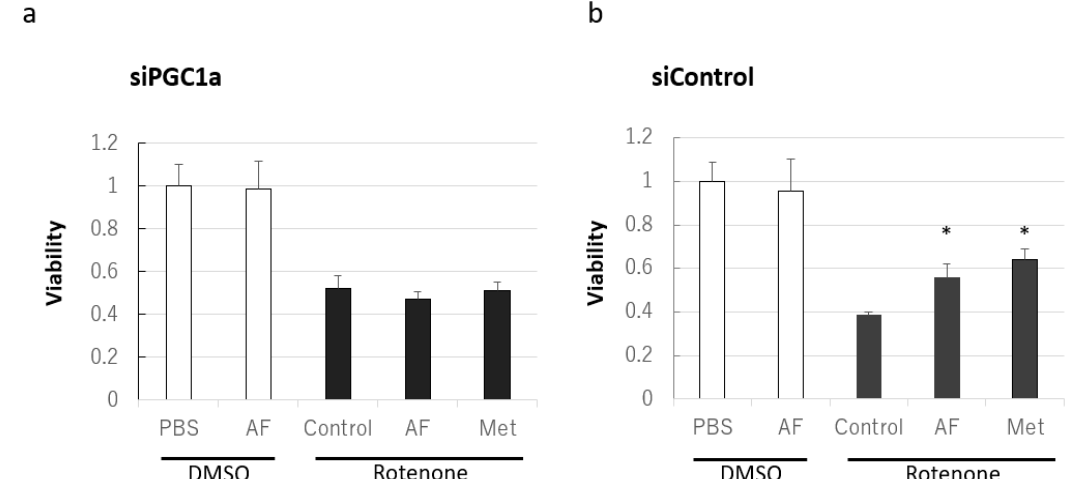
Figure 6. Effects of PGC-1 α silencing on rotenone-induced cytotoxicity in cultured PC12 cells treated with 1,5-AF or metformin. ( a ) Silencing of PGC-1 α by PPARGC1A small interfering RNA (siRNA) attenuated the protective effects of 1,5-AF and metformin on rotenone-induced cytotoxicity, evaluated using the MTT assay (one-way ANOVA followed by Dunnett’s test). ( b ) 1,5-AF and metformin protect against rotenone-induced cytotoxicity in negative control siRNA-transfected cells, evaluated using the MTT assay (one-way ANOVA). All data are expressed as the mean ± standard error of the mean. * p < 0.05. AF, 1,5-anhydro-D-fructose; DMSO, dimethyl sulfoxide; Met, metformin; PBS, phosphate-buffered saline; PGC-1 α , peroxisome proliferator-activated receptor- γ coactivator 1 α .